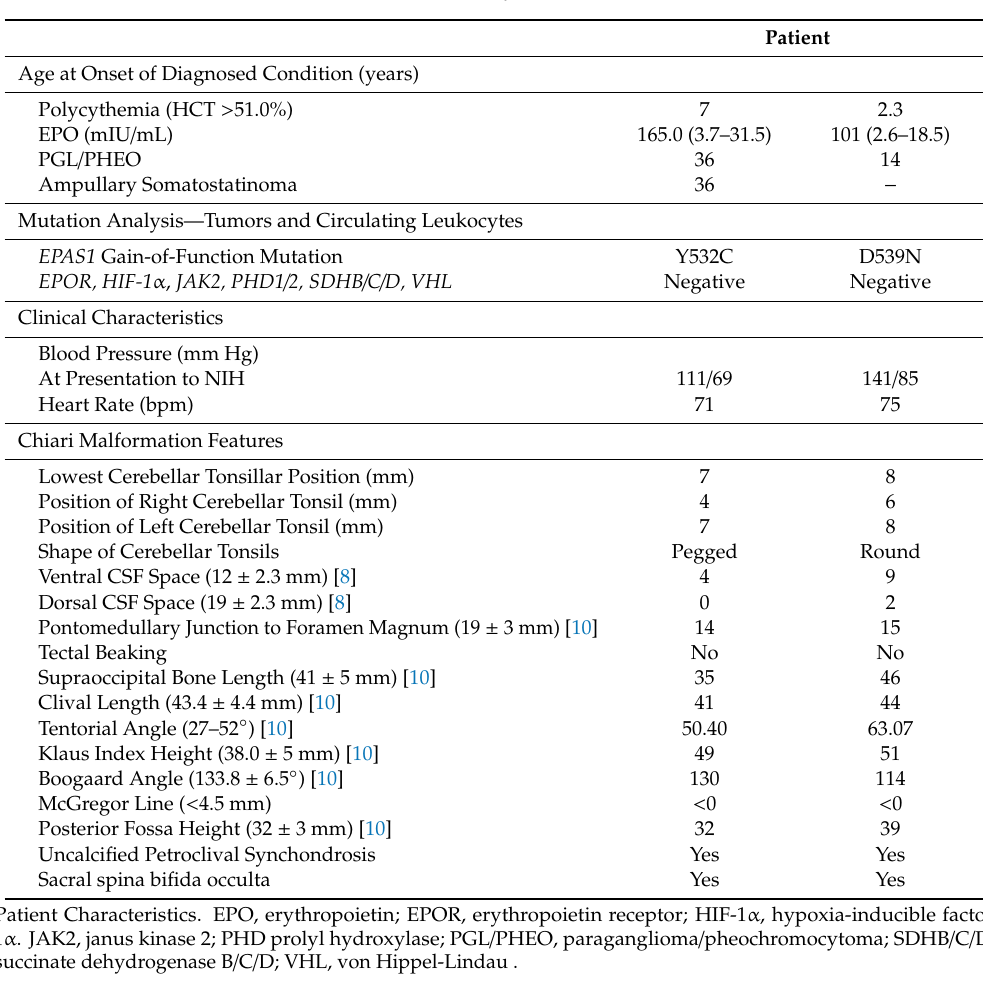
Table 1. EPAS1 G ain-of-Function Syndrome Patient Characteristics.